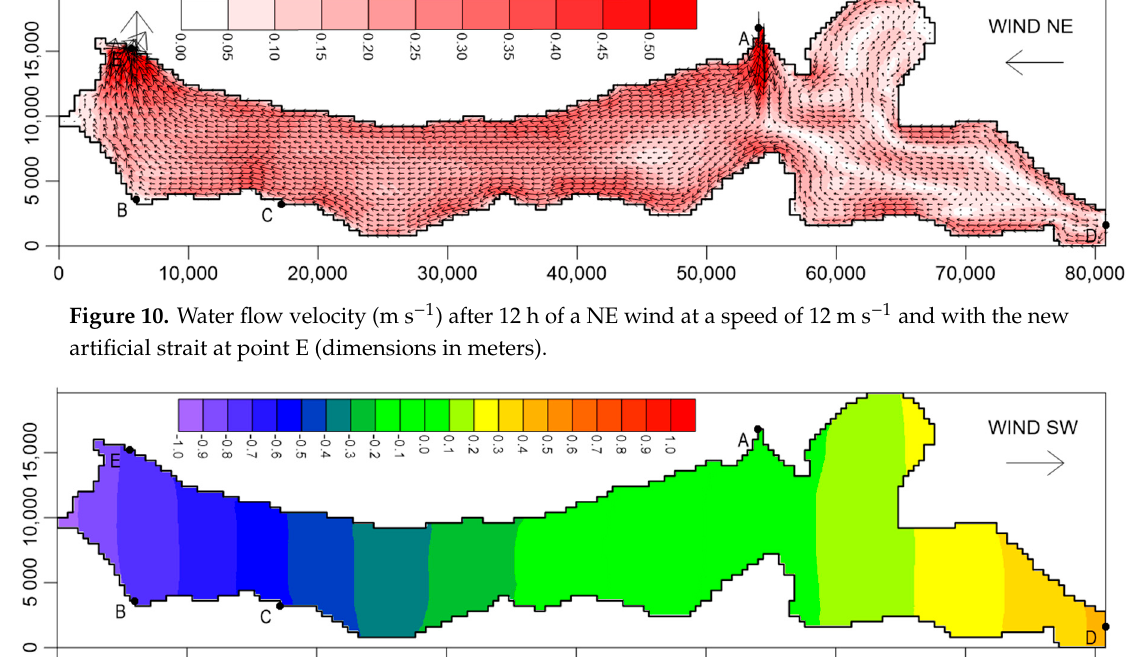
Figure 11. Water surface elevation (m a.s.l.) after 12 hours of a SW wind at a speed of 12 m s -1 and without the new artificial strait at point E (dimensions in meters).